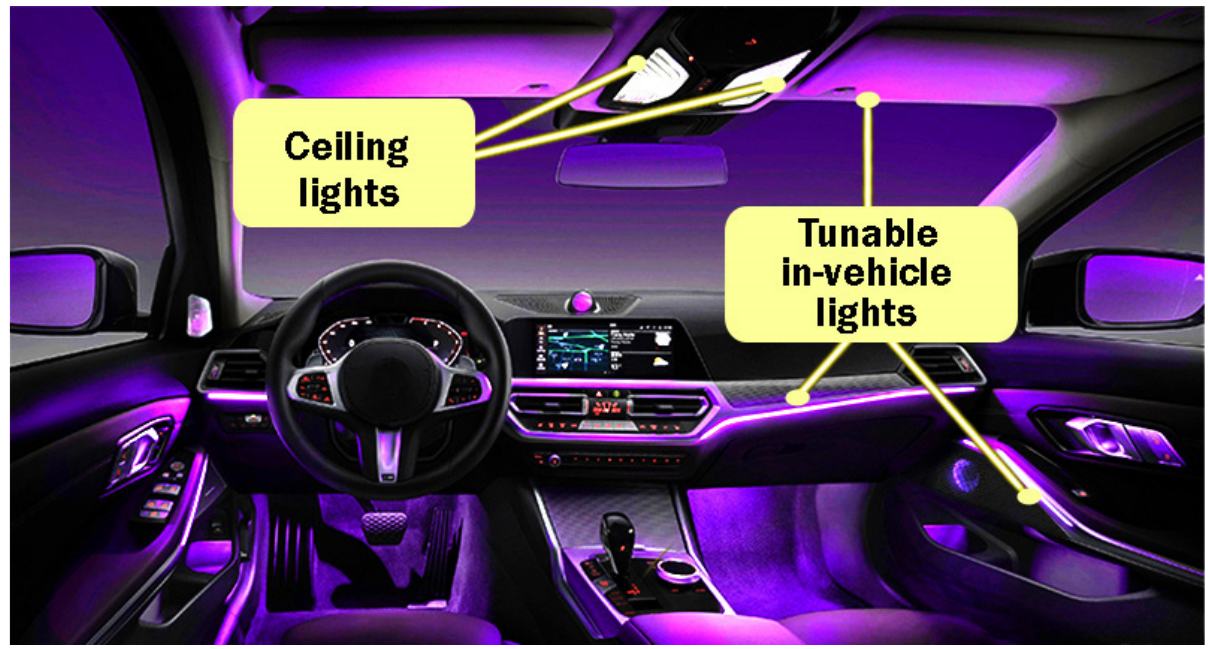
Figure 2. Tunable in-vehicle ambient lighting system.